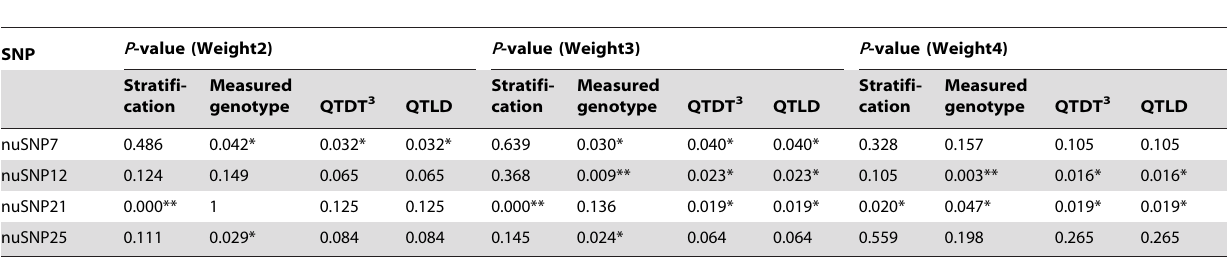
Table 3. Association of nuclear SNPs with weight 1 using family-based quantitative trait linkage disequilibrium (QTLD) analysis, the measured genotype test and the quantitative disequilibrium test (QTDT) 2